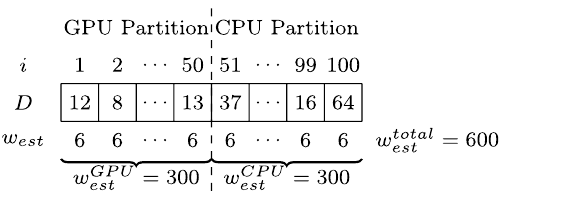
Fig. 4 Representation of the static partitioning strategy based on the query points, where D is the dataset sorted by workload, i refers to the indices of the query points in D , and W est the workload of the points using the equal workload assumption and that is determined total by our model (and where w est is the estimated workload of HEG- J oin ). As we use the equal workload assumption, each query point is therefore assigned the same workload. Furthermore, we consider in this example that the model considers the CPU and GPU to have the same throughput, and thus assigns the same estimated workload to CPU = w GPU both processors ( w est est ), i.e., the same number of query